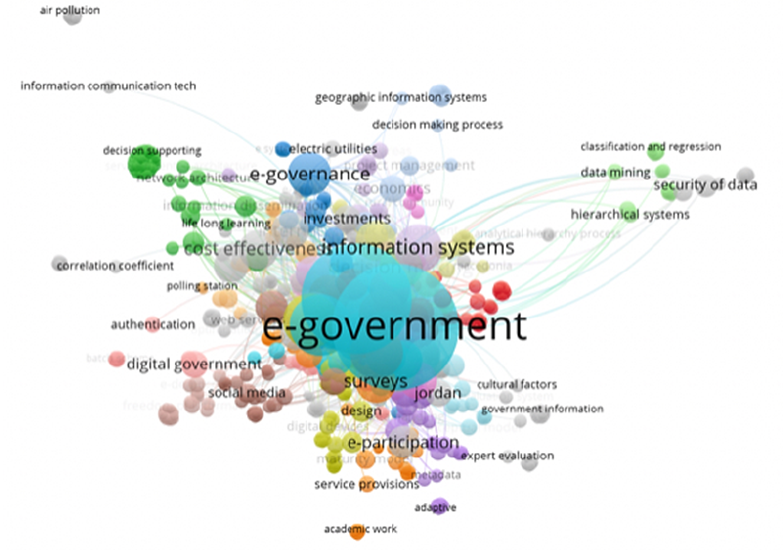
Figure 4. Co-occurrence of words in the documents retrieved.